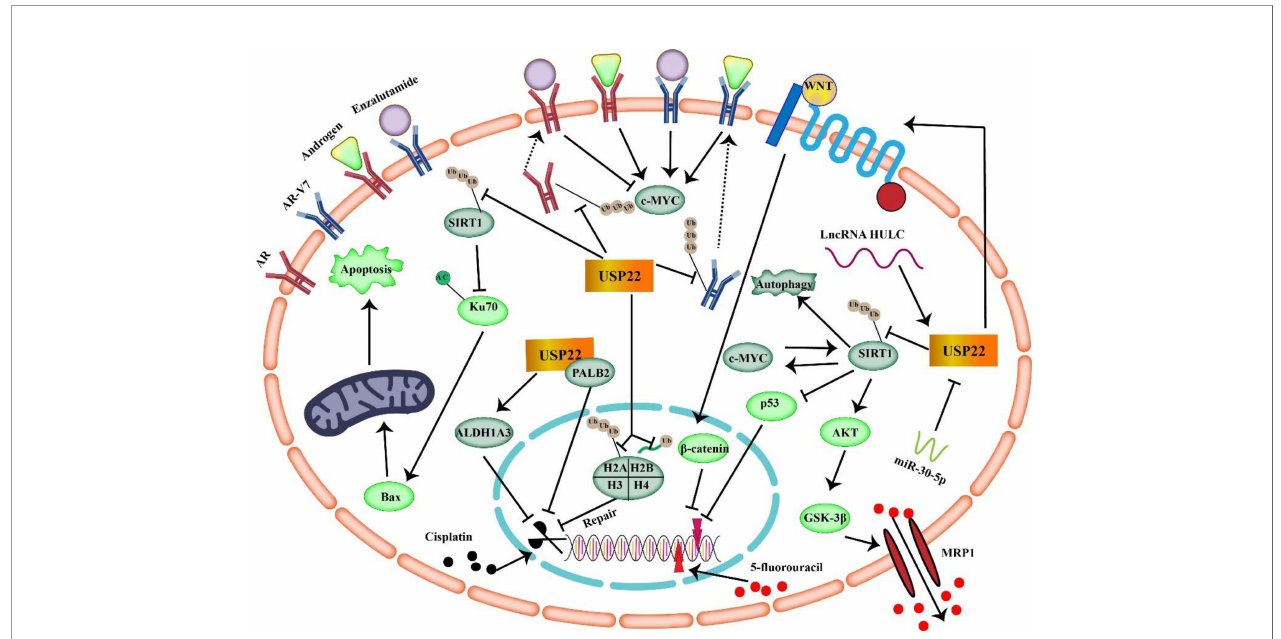
FIGURE 4 | USP22 mediates tumor resistance mechanisms to enzalutamide, cisplatin, and 5- fl uorouracil (USP22 can make cancer cells resistant to 5-FU through SIRT1 and Wnt/ b -catenin signaling. USP22 mediates tumor resistance to cisplatin by acting on ALDH1A3, PALB2, H2A, H2B, and SIRT1. Binding of USP22 to AR/ AR-V7 prevents AR/AR-V7 protein degradation and enhances tumor resistance to